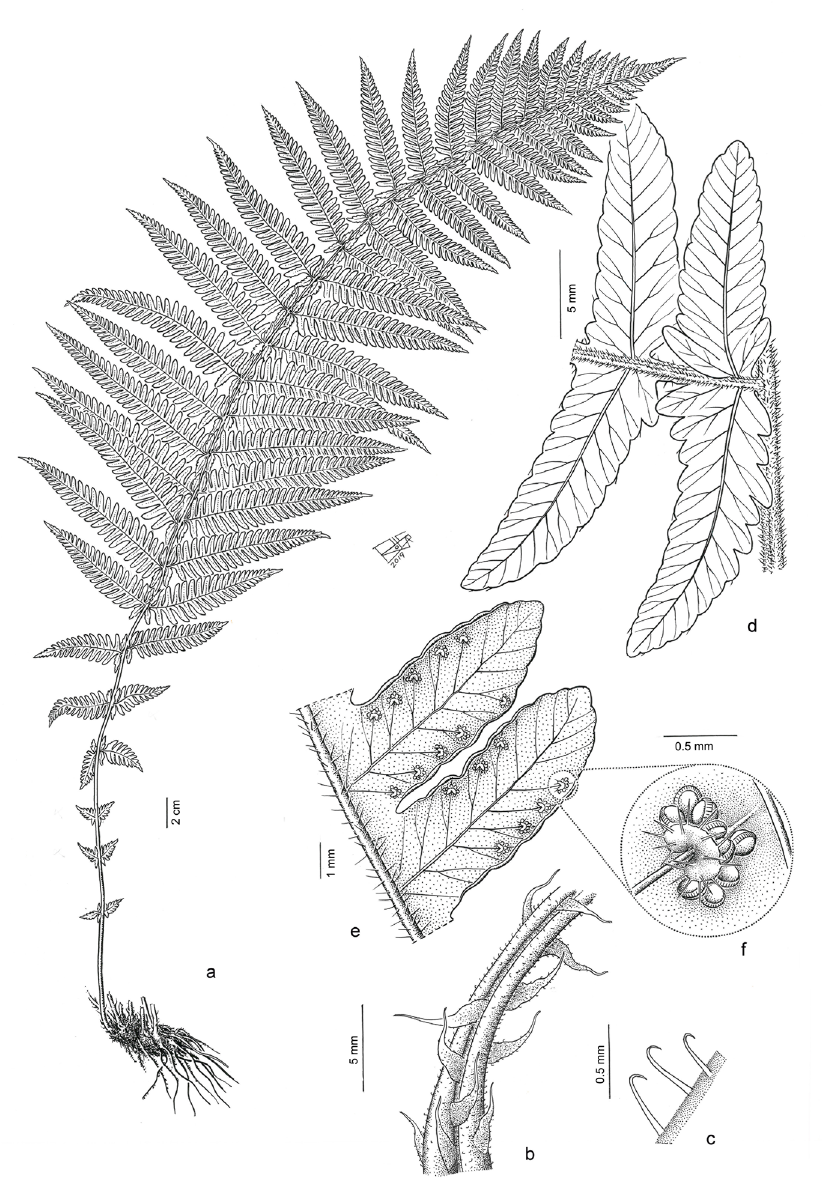
Figure 2. Amauropelta